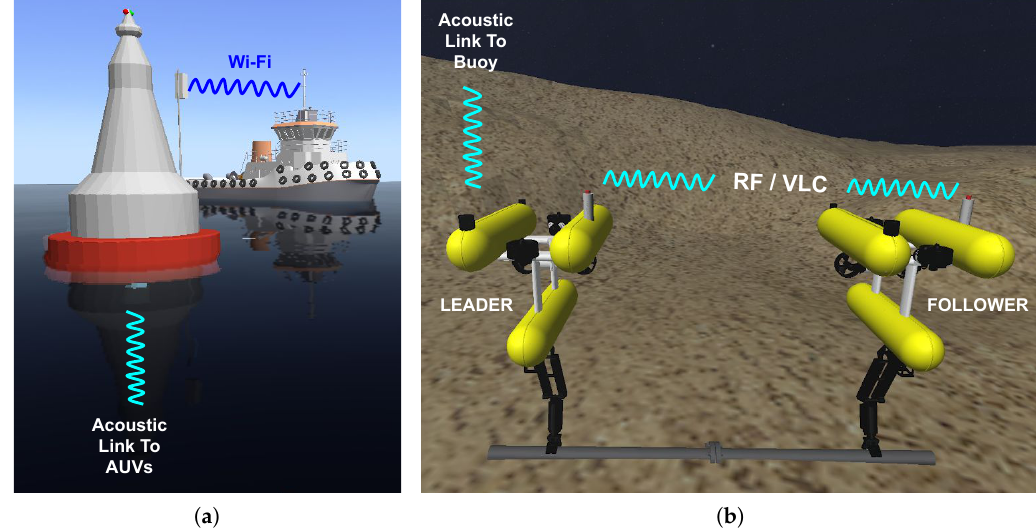
Figure 1. Illustration of the underwater wireless communication system envisioned for the TWINBOT project: ( a ) on the surface, an acoustic link from the boat or a buoy will provide communication with the AUVs; and ( b ) on the seafloor, the leader will incorporate an acoustic modem to communicate with the surface. A short range communication based on RF or VLC will be used between the AUVs on the